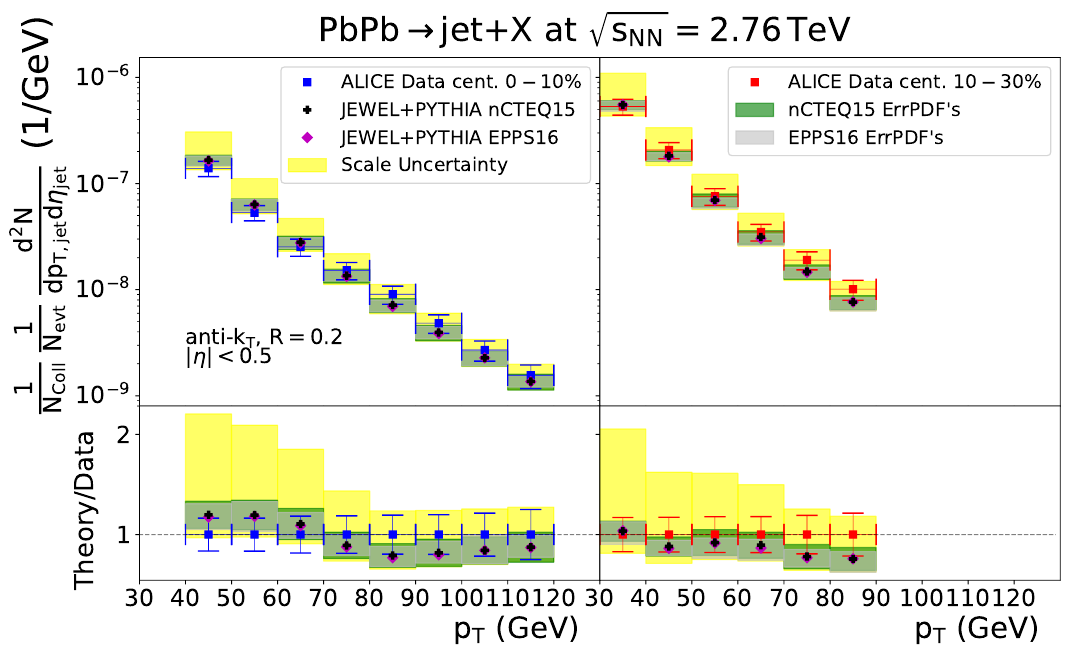
Figure 5 . Transverse momentum distributions of jets with radius R = 0 . 2 in PbPb collisions at √ s NN = 2 . 76 TeV measured by ALICE in the rapidity range | η | < 0 . 5 and the centrality ranges 0 – 10% (left) and 10 – 30% (right) [6] and calculated with JEWEL. Scale (nuclear PDF) uncertainties are shown as yellow (green and grey) shaded